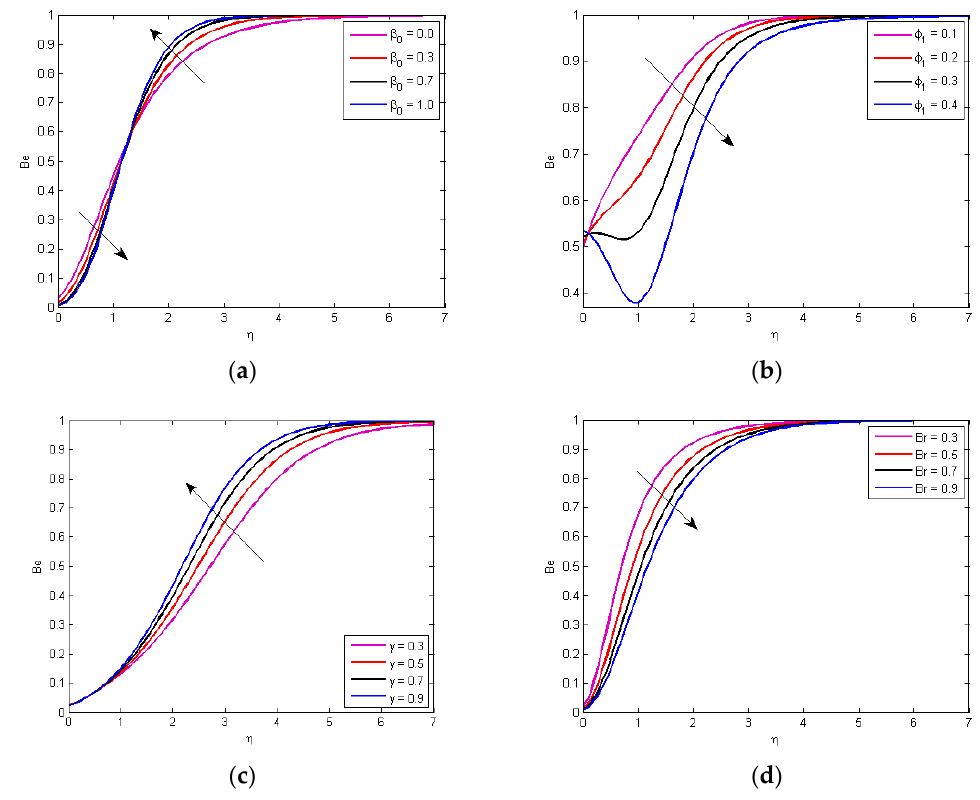
β φ γ , ( b ) is 1 , ( c ) is , ( d ) is Br . φ β α γ , , 0 , , and Fr . − 3.6675